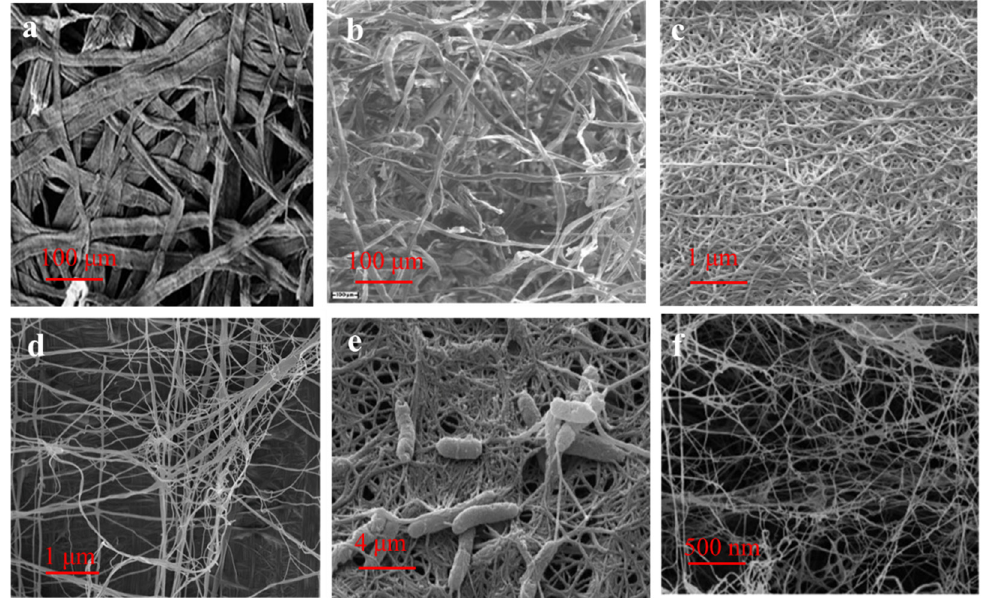
Figure 3. SEM images of cellulose obtained from different sources: ( a ) softwood, reprinted with permission from [43], 2012, RSC; ( b ) cotton, reprinted with permission from [44], 2013, Elsevier; ( c ) tunicate, reprinted with permission from [45], 2015, Elsevier; ( d ) algae, reprinted with permission from [46], 2015, Springer; BC, ( e ) reprinted with permission from [47], 2016, RSC, and ( f ), reprinted with permission from [48], 2022, Elsevier.